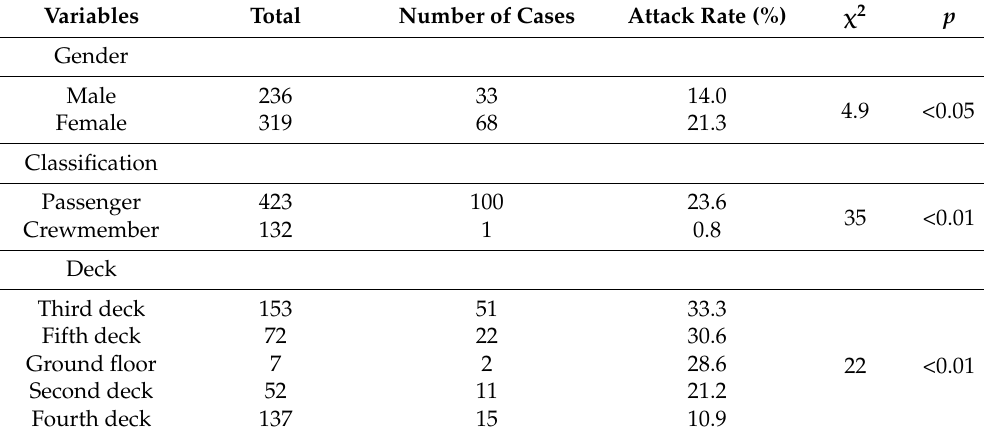
Table 1. Attack rates across different demographics in the norovirus outbreak occurred on the cruise ship, Chongqing, China,